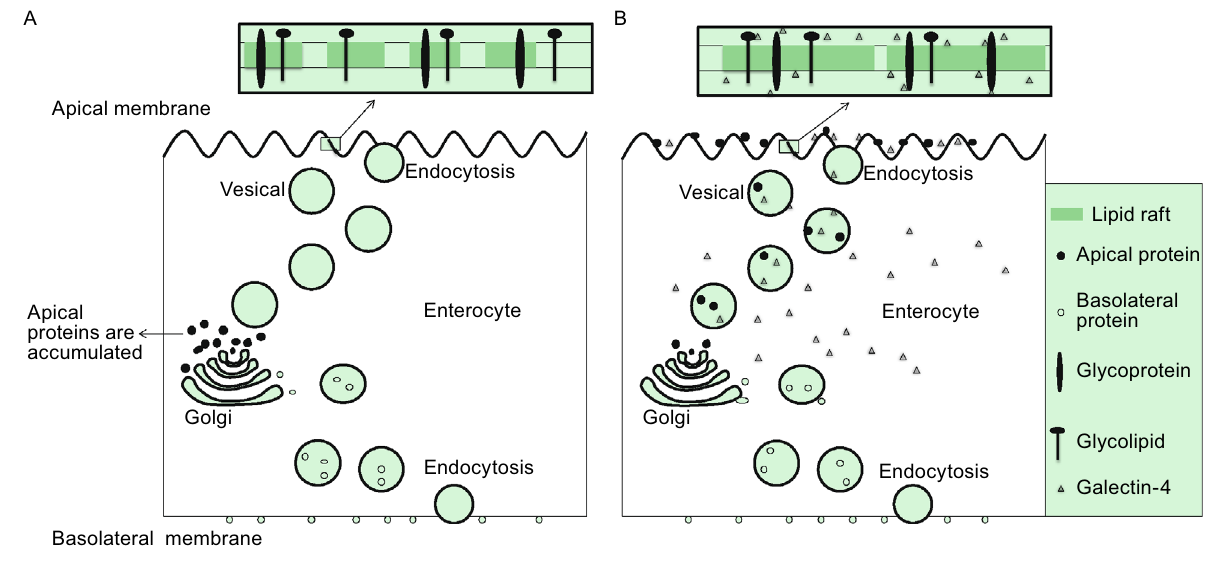
Figure 1. Galectin-4 participates in apical proteins traf fi cking and lipid raft stabilization. (A) In the absence of galectin-4, the apical proteins are accumulated intracellularly. Lipid rafts are small in the plasma membrane, containing only a subset of glycoproteins and glycolipids. (B) In the presence of galectin-4, apical proteins are traf fi cked to the apical plasma membrane. Lipid rafts are capable of clustering based on galectin-4 crosslinking to glycoproteins and glycolipids in